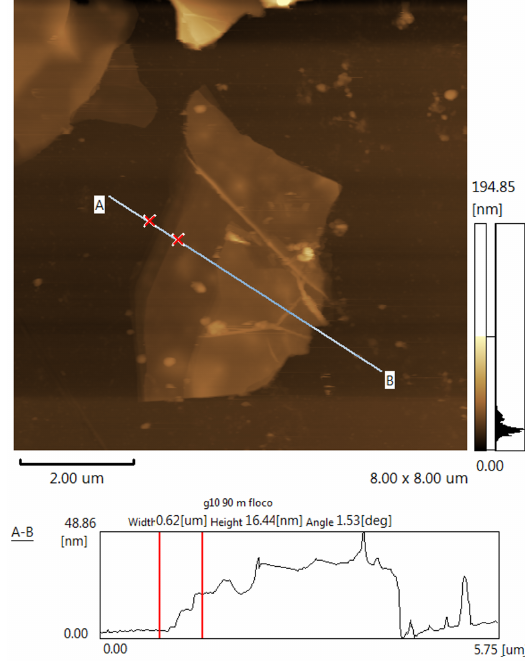
Figure 4. AFM mapping and thickness profile of MLG flake obtained with dispersion B, treated for 60 minutes in ultrasound and 10 immersions. The red crosses situated over the line A-B in micrograph represents the red lines in the surface profile (below micrograph) and were used to determine the graphene flake